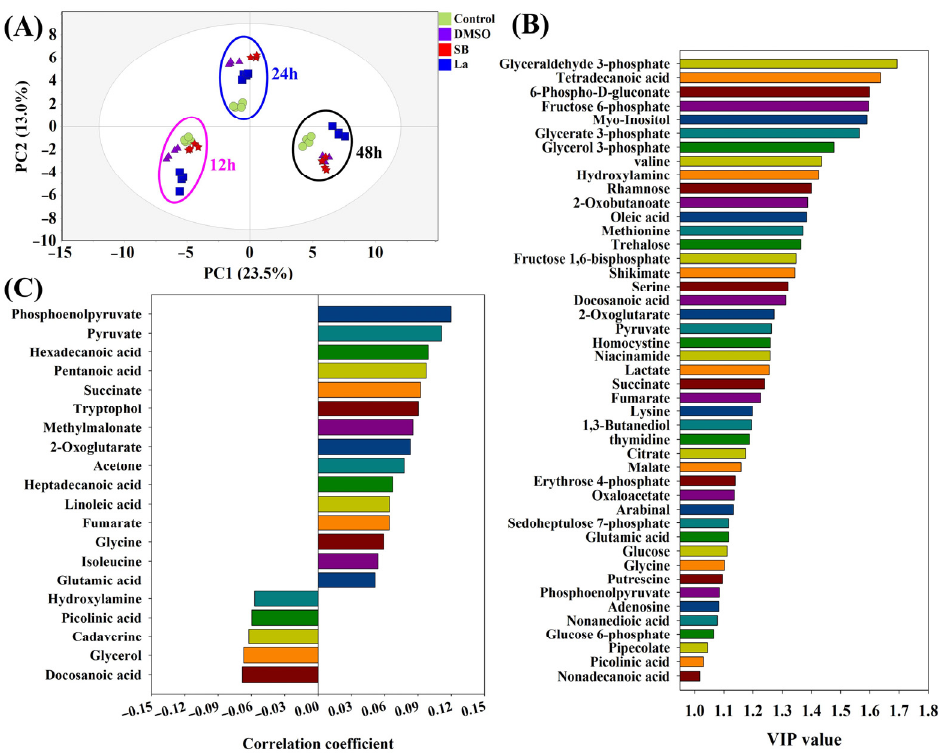
Figure 3. PCA and PLS-DA analyses of intracellular metabolites under different chemical elicitor treatments. Compared with the control, DMSO, SB, and LaCl 3 were added into the medium at 72 h of the batch fermentation, respectively. After an additional 12 h, 24 h, and 48 h of culture, intracellular metabolites of each sampling time point were analyzed by different multivariate statistical analysis methods, respectively. ( A ) PCA-derived score plots; ( B ) VIP score plot derived from PLS-DA analysis; ( C ) the metabolites correlated with rapamycin using PLS-DA.